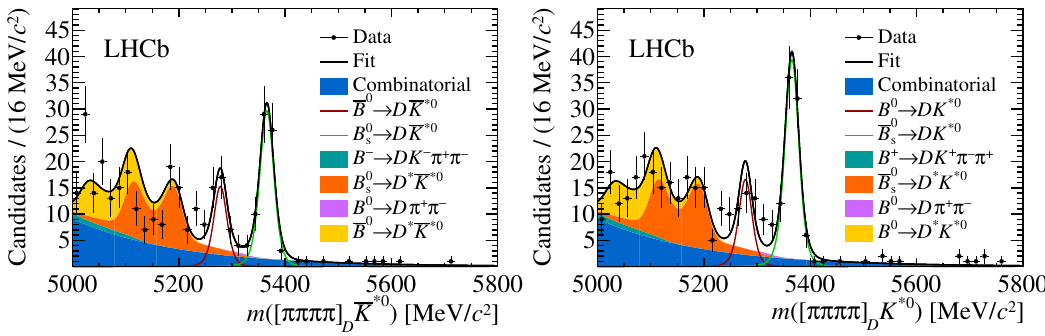
Figure 4 . Invariant-mass distributions (data points with error bars) and results of the (cid:12)t (lines and coloured areas) for the four-body GLW mode (left) B 0 ! D ( (cid:25) + (cid:25) (cid:0) (cid:25) + (cid:25) (cid:0) ) K (cid:3) 0 , (right) B 0 ! D ( (cid:25) + (cid:25) (cid:0) (cid:25) + (cid:25) (cid:0) ) K (cid:3) 0 .